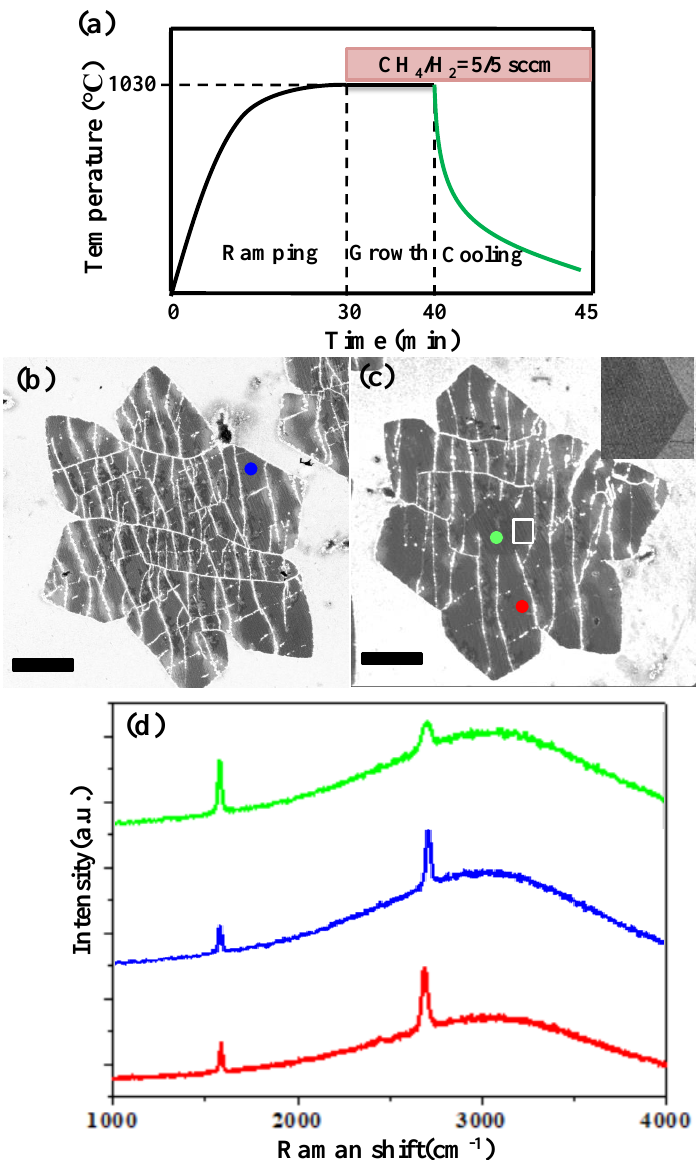
Figure 1. ( a ) LPCVD synthesis parameters used for the wrinkled graphene synthesis. ( b ) SEM image of as synthesized wrinkled monolayer graphene domain. ( c ) SEM image of as synthesized wrinkled multilayer graphene domain and inset is the magnified picture of the multilayer edge. ( d ) Raman spectra of di ff erent graphene areas shown by the colored dot in ( b , c ). All scale bars are 5 µ